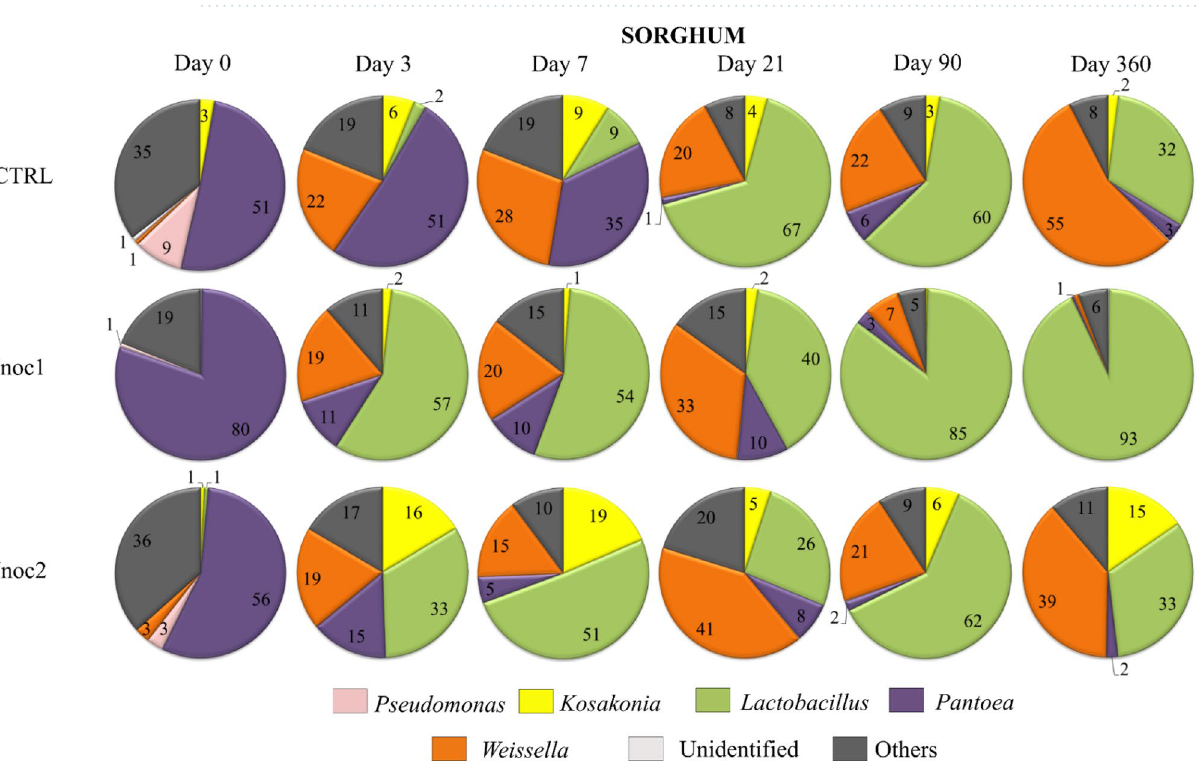
Figure 4. Main genera dynamics (%) of bacterial communities of rehydrated sorghum grain silages after 0, 3, 7, 21, 90 and 360 days of fermentation. CTRL non-inoculated, Inoc1 : Lactobacillus plantarum and Propionibacterium acidipropionici , Inoc2 Lactobacillus